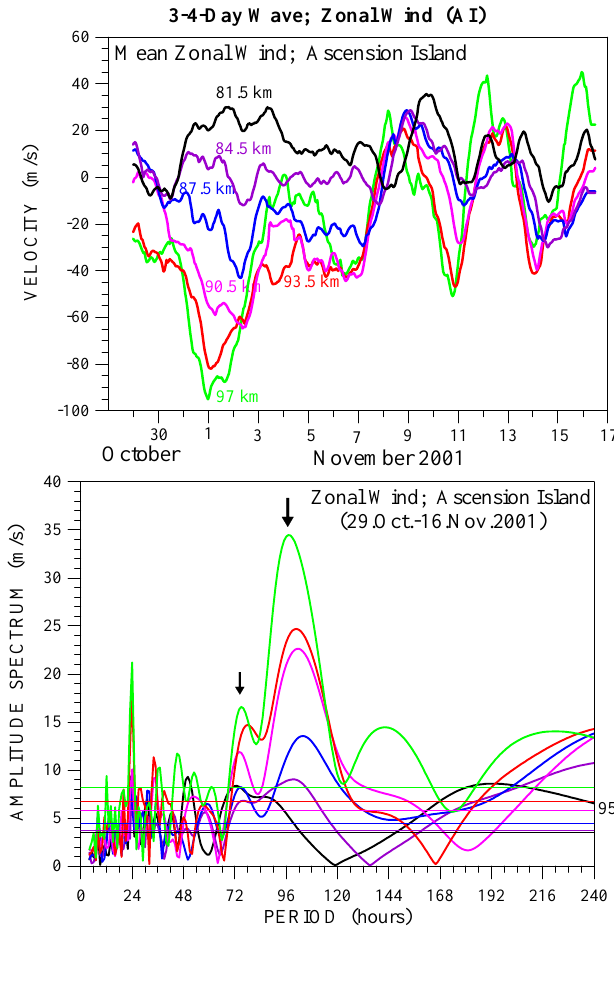
Fig. 3. Variability of the mean zonal winds observed at six altitudes indi- cated by different colours (black for h=81km; purple for h=84.5km; blue for h=87.5km; magenta for h=90.5km; red for h=93.5km and green for h=97km) during the interval 29 Oct.– 16 Nov. 2001 (upper panel). Amplitude spectra of the zonal winds observed in the same time interval and calculated from the hourly data by the correloperi- odogram analysis. The examined peaks centred at 3 and 4 days are marked by arrows (bottom